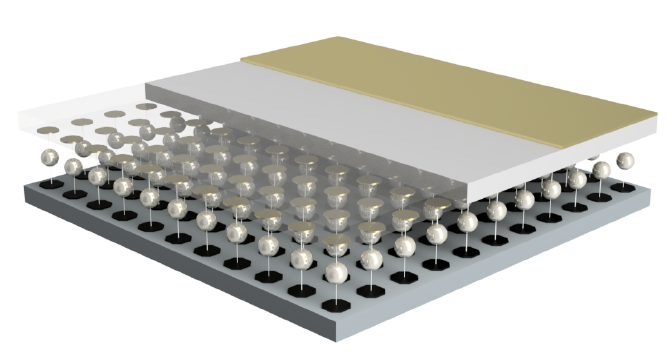
Figure 3. LISe Timepix layering diagram.